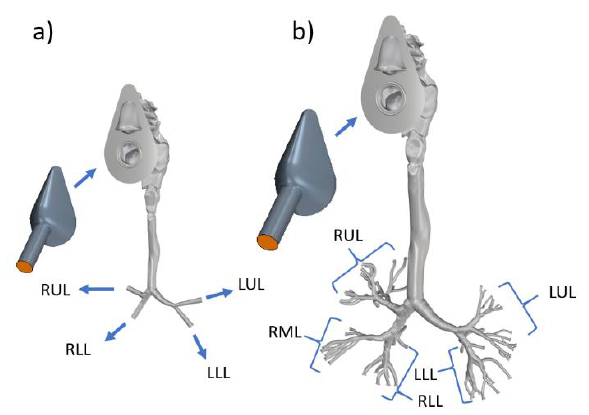
Fig. 1. Child (a) and adult (b) digital model of respiratory